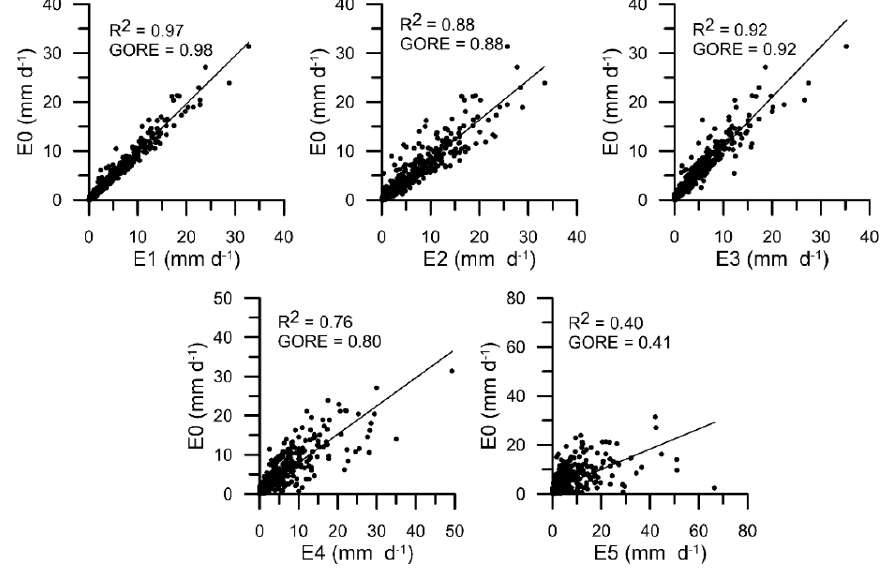
Figure 4. Scatter plot, determination coefficient (R 2 ), and GORE of the estimated spatial rainfall of catchment S8 from monitoring scenarios E1–E5 (axis X) against the reference estimated rainfall from monitoring scenario E0 (axis Y).